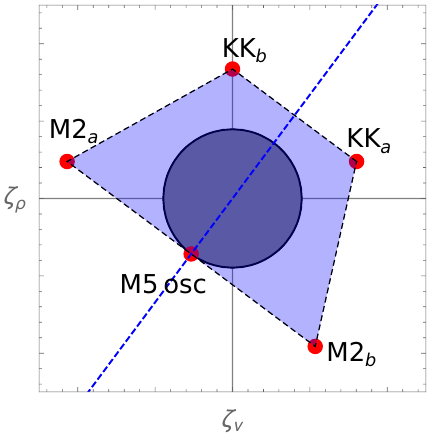
Figure 3. The convex hull condition for M-theory on M (2) a × M (2)